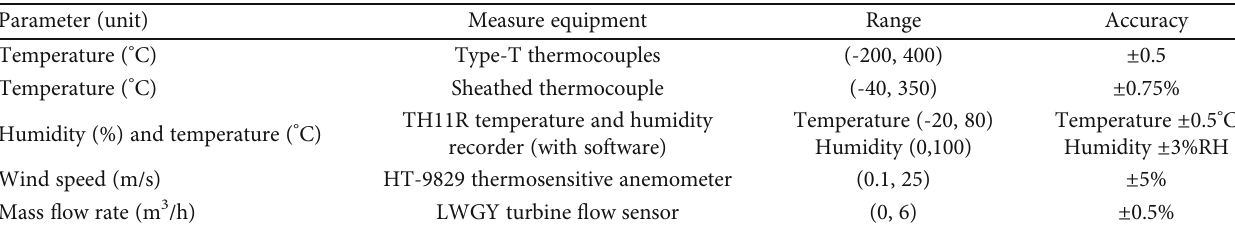
Figure 4: Measuring parameters and instrument in the present study. Table 2: Parameters of the measuring